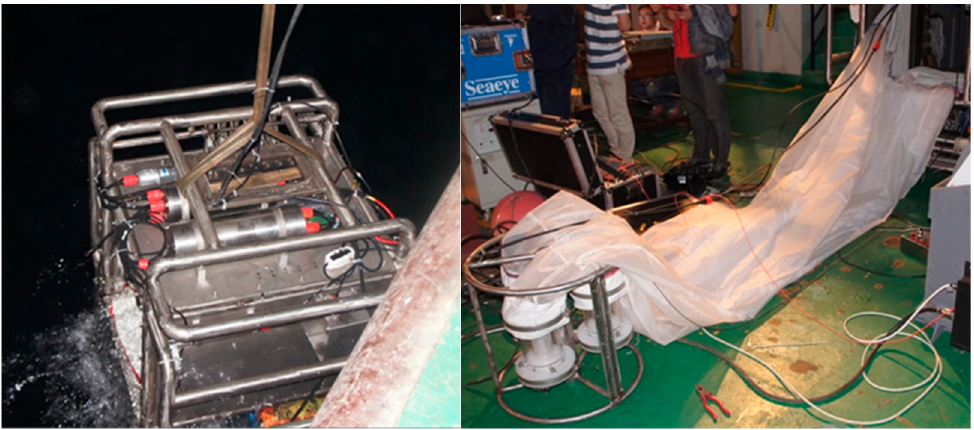
Figure 11. The sea trial site of the collector.